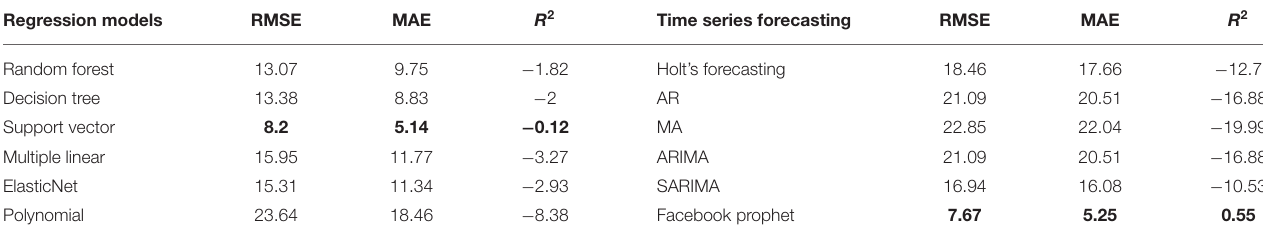
TABLE 12 | Performance metrics comparison table for Thane. Regression models Random Forest